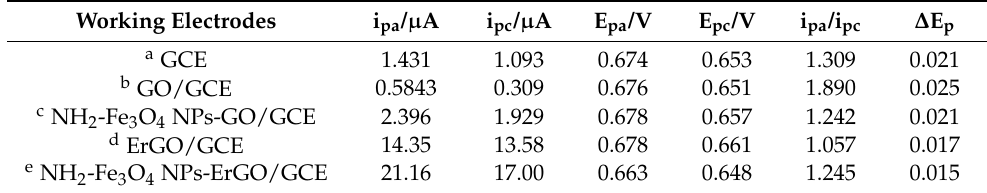
Table 1. Electrochemical response data of rutin (10 µ M) at different decorated